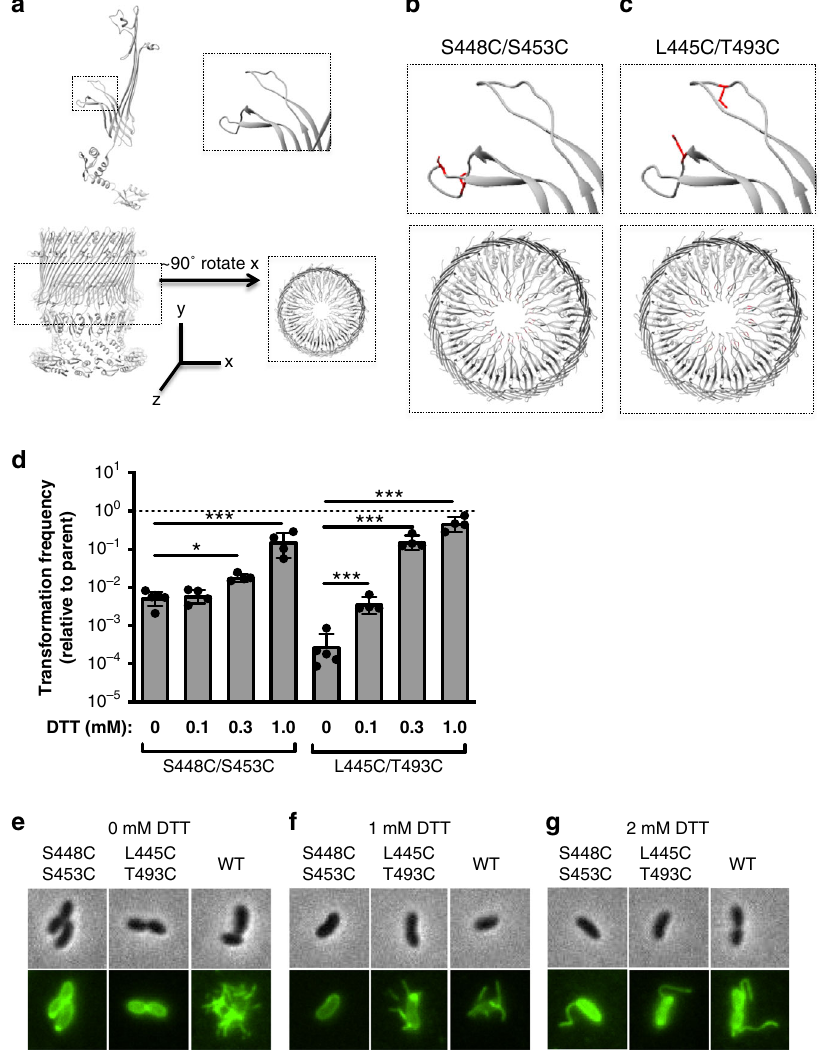
Fig. 3 Cysteine pair mutants lock the gate, reduce piliation, and reversibly inhibit transformation. a top: the atomic model of VcPilQ is shown as one chain. The upper and lower beta hairpins of the gate are highlighted in a dashed line box (left) and magni fi ed (right). Bottom: the atomic model of VcPilQ is shown as a multimer and a dashed line rectangle highlights the gate region (left), which is magni fi ed (right) after a 90° rotation about the x- axis. The coordinate system is shown. The magni fi ed regions from ( a ) are shown for ( b ) the VcPilQ S448C/S453C mutant, which locks the lower gate and for ( c ) the VcPilQ L445C/T493C mutant, which links the upper and lower gates. In ( b , c ) the residues mutated to cysteine are shown in red. d The transformation frequency of two cysteine pair VcPilQ mutants (left: S448C/S453C (Strain TND2169) and right: L445C/T493C (Strain TND2170)) is plotted. Data are normalized to the parental strain that expresses wild-type VcPilQ (Strain TND2140). Natural transformation assays were performed in the presence of varying concentrations of dithiothreitol (DTT) (0 – 1.0 mM). Data are from at least four independent biological replicates and shown as the mean ± standard deviation. The dashed line indicates the transformation frequency expected if mutants are equivalent to the parental strain expressing wild-type VcPilQ. Statistical comparisons were made by one way ANOVA with Tukey ’ s posttest. * p < 0.05, *** p < 0.001. The raw data are available in Supplementary Fig. 6. Representative phase contrast (top) and epi fl uorescence images (bottom) of V. cholerae in the hyperpiliated background expressing wild-type (WT) VcPilQ (Strain TND2244), or a cysteine mutant pair (S448C/S453C (Strain TND2242) or L445C/T493C (Strain TND2243)) grown in the presence of e 0 mM, f 1 mM, or g 2 mM dithiothreitol (DTT) prior to labeling with AlexaFluor 488-maleimide to visualize bacterial pili. More than 200 cells were imaged per condition and representative images of cells with pili are shown. In conditions where no cells analyzed exhibited an external pilus, a representative image of a non-piliated cell is